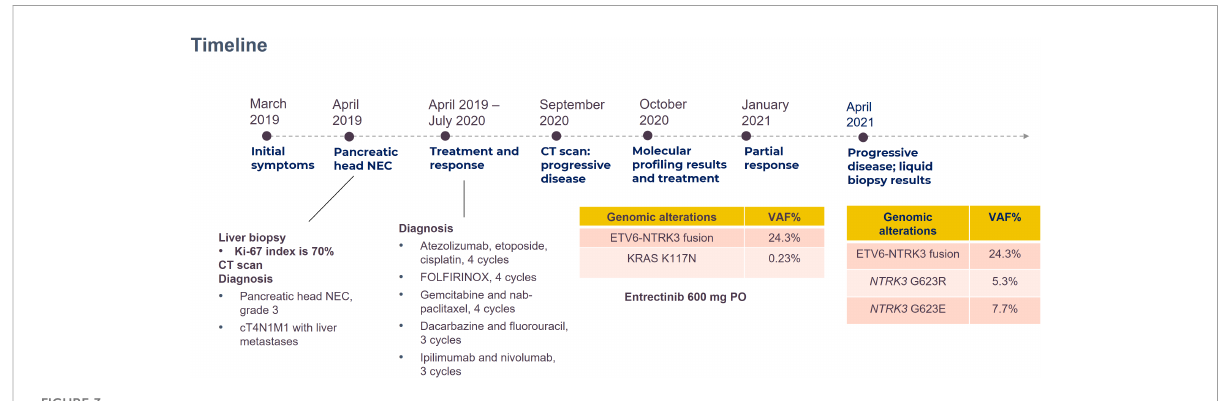
FIGURE 3 Scheme of clinical course with gene mutation tests.